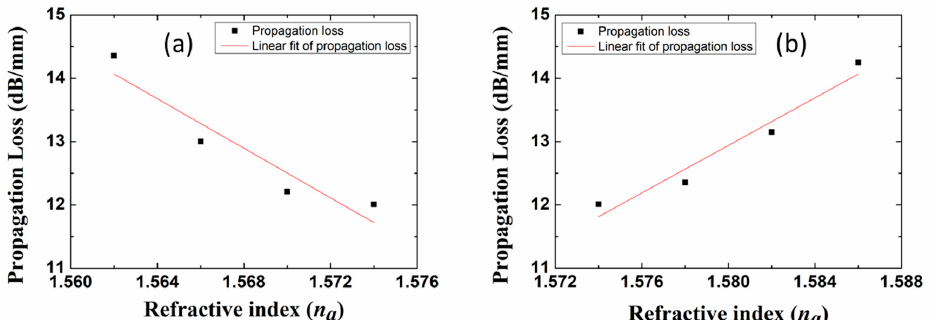
Figure 8. Propagation loss (MPA a ) as a function of n a ; ( a ) n a < n SU-8 , and ( b ) n a > n SU-8 .